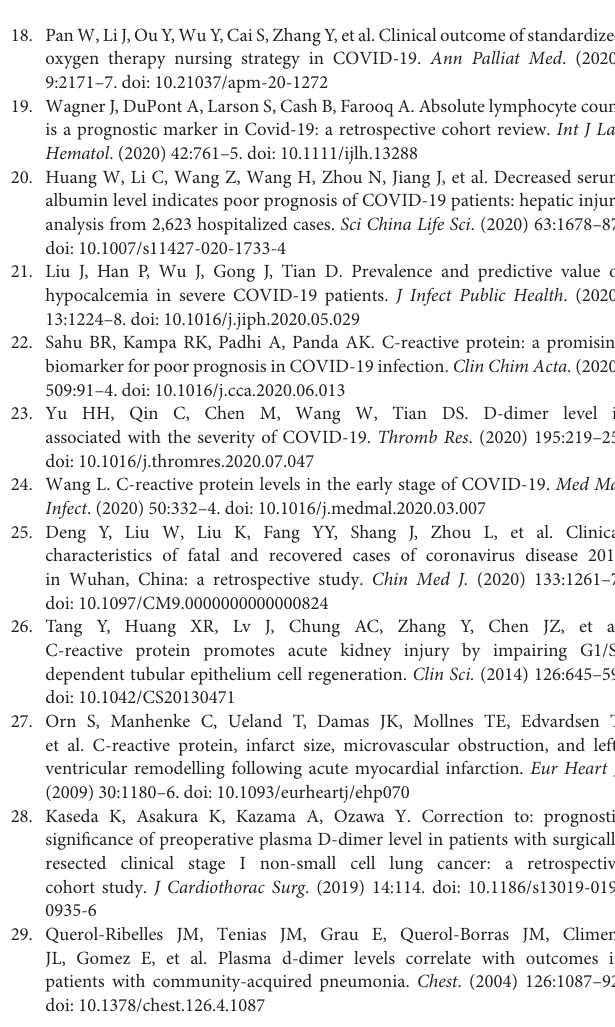
curve analysis (DCA) of the nomograms compared for the 15- (E) , 30- (F) , and 45 (G) days survival in COVID-19 patients, respectively. Supplementary Figure 3 | Evaluation of the nomogram through the ROC